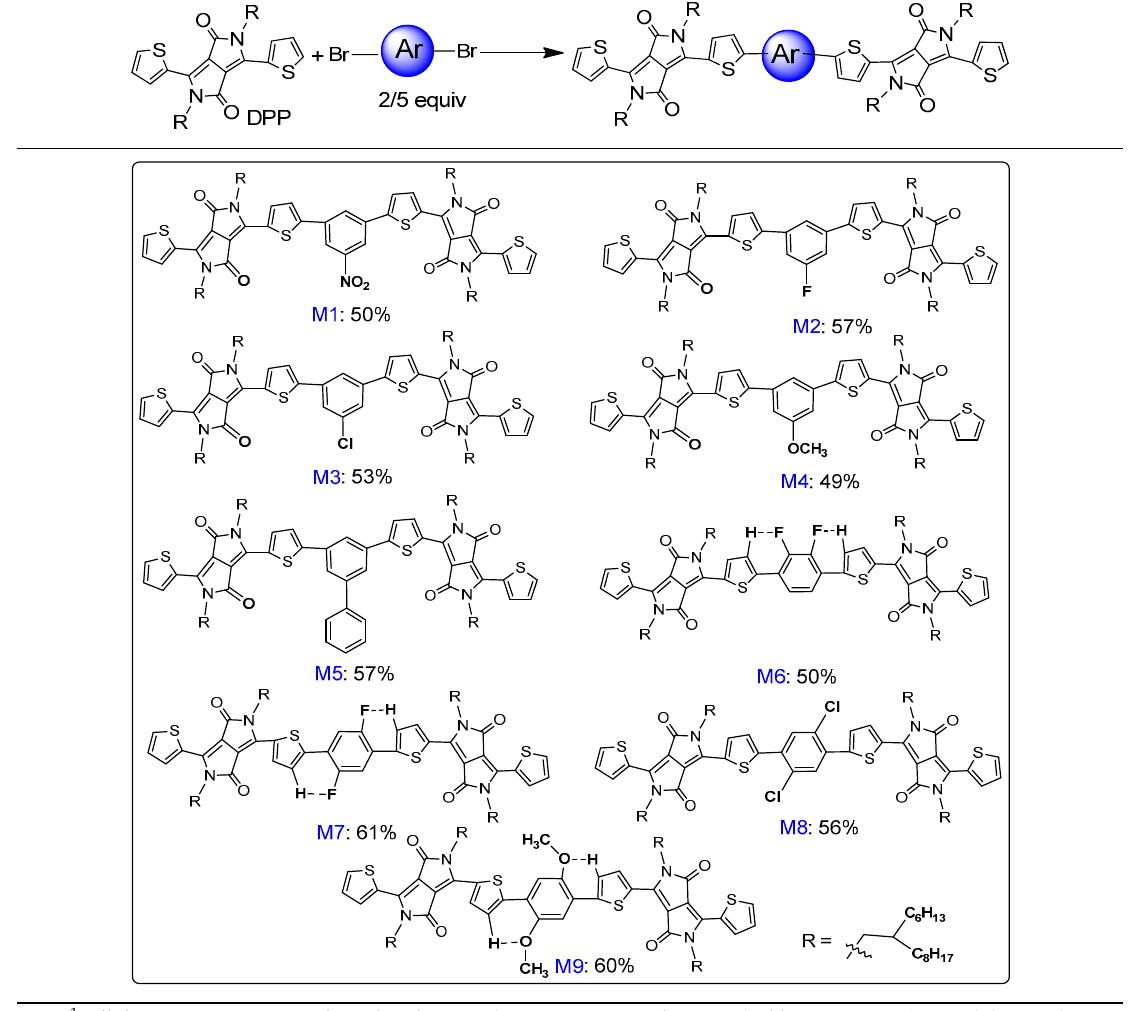
Table 2. Optical and electrochemical properties of molecules Ms1~9 .